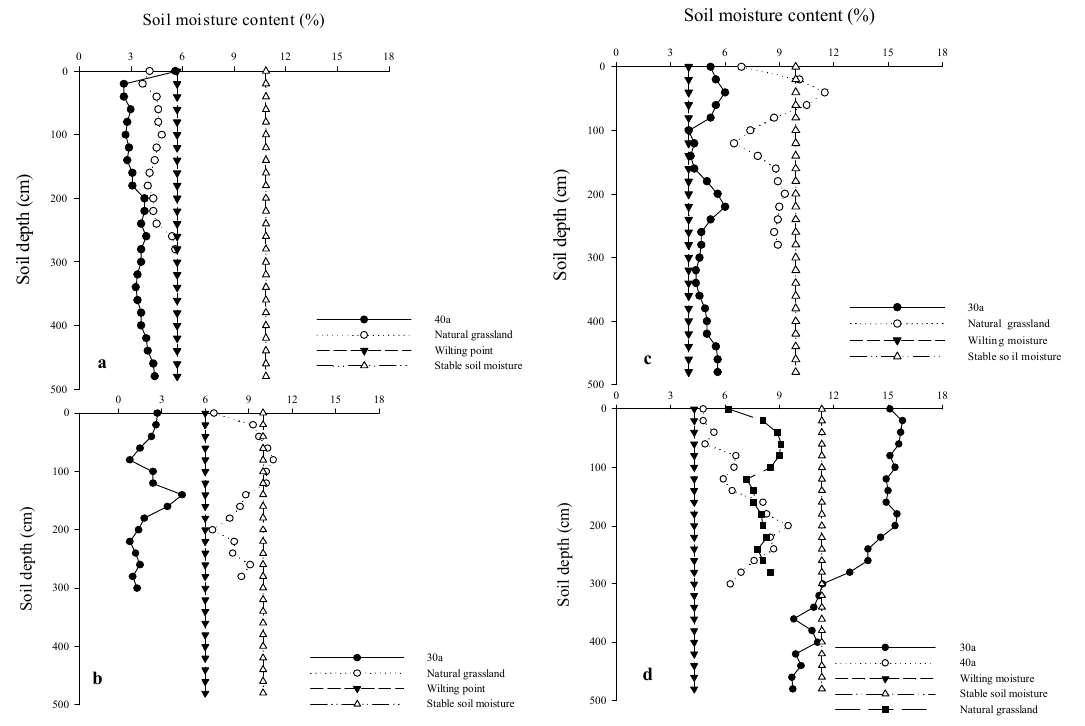
Figure 3. Distribution of desiccated-soil layers under R. pseudoacacia forests in the typical northern, temperate, semi-arid, drought-prone steppe zone of the Loess Plateau. Note, ( a – d ) in Figure 3 were represented as sampling sites in Hequ, Shenmu, Suide and Ansai, respectively.